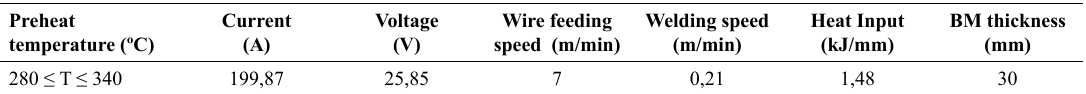
Table 2. Welding procedure